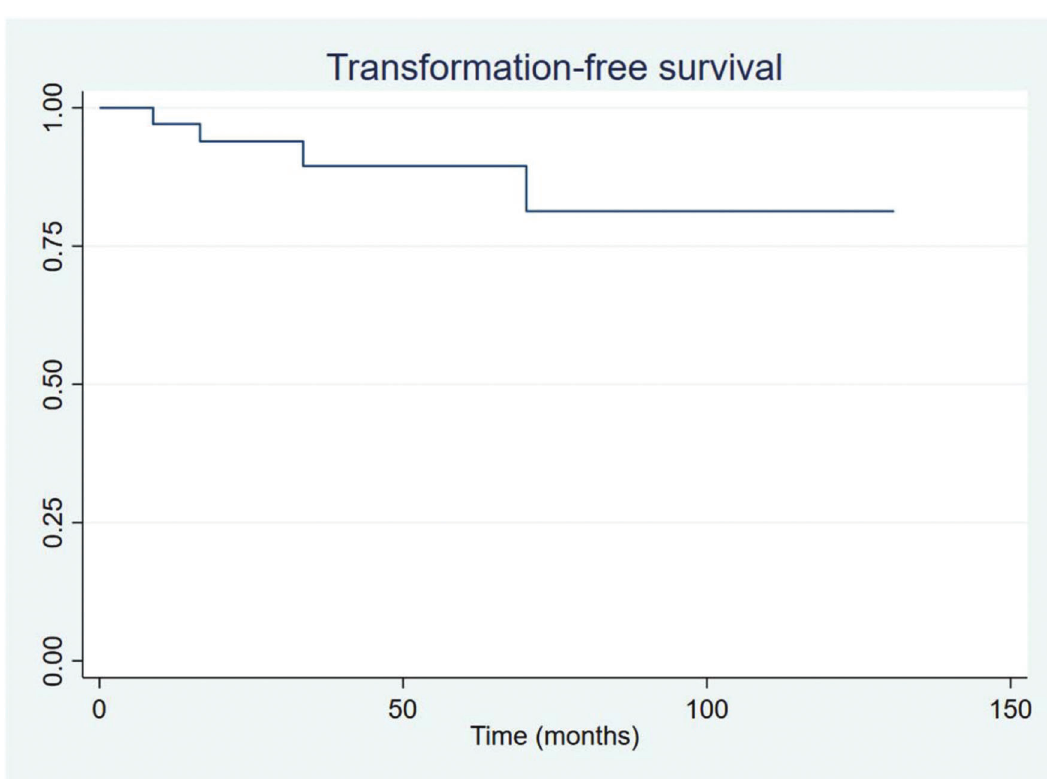
Fig 2 - Transformation-free survival.